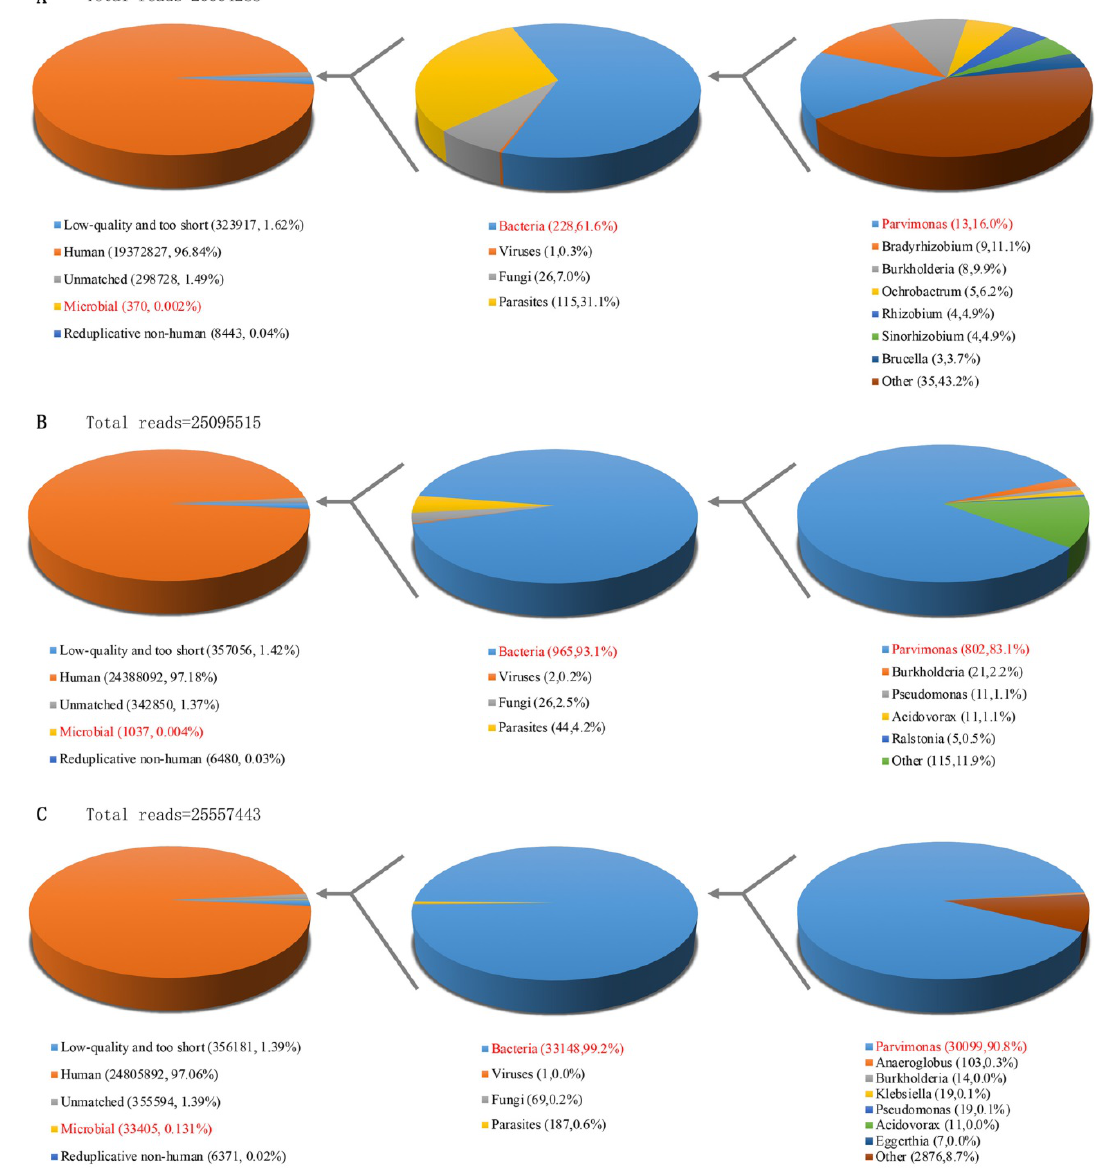
Figure 4. Taxonomic classification of reads by bioinformatic analysis of sequenced data from preoperative synovial fluid (A), intraoperative synovial fluid (B) and sonicate fluid (C).